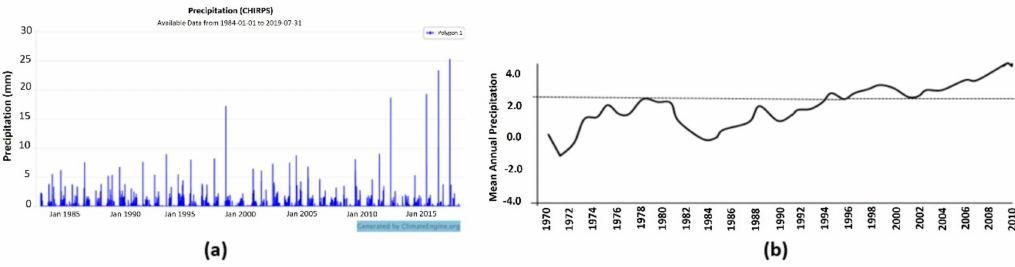
Figure 13. ( a ) Precipitation graph from 1985 to 2019 generated by using the ClimateEngine platform, and ( b ) mean annual precipitation graph obtained from [92].